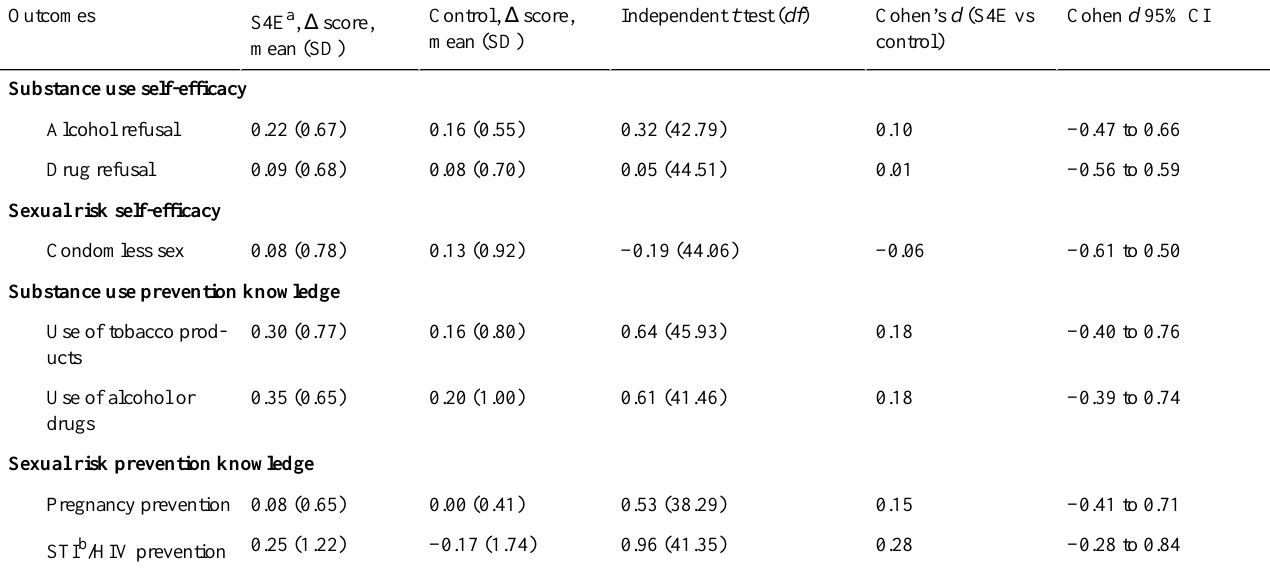
Table 2. Self-efficacy and prevention knowledge by